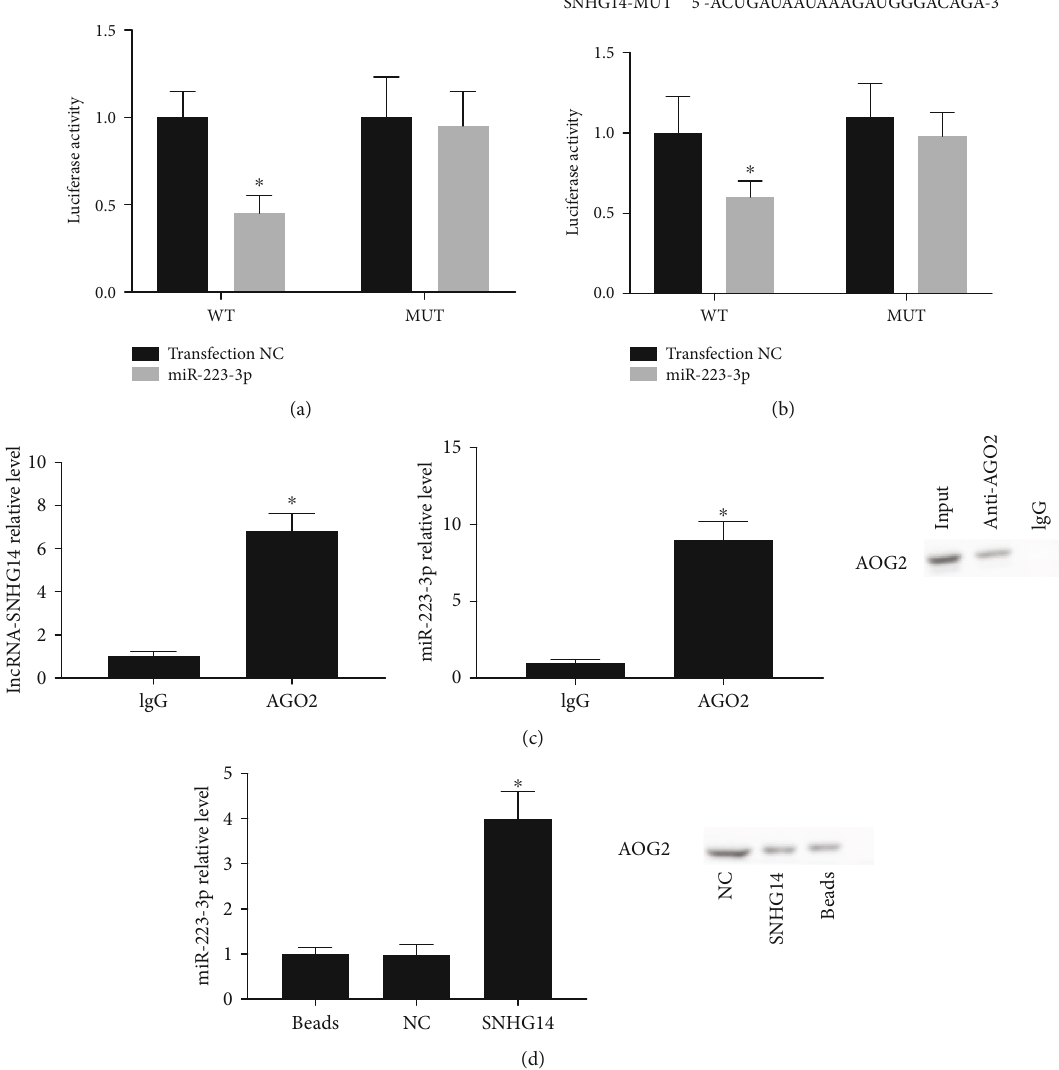
Figure 3: lncRNA-SNHG14 interacted with miR-223-3p/Foxo3a as a ceRNA. (a, b) The binding relationship of lncRNA-SNHG14/miR- 223-3p and miR-223-3/Foxo3a was determined by dual-luciferase reporter assay. (c) In RIP assay, lncRNA-SNHG14 (left) and miR-223- 3p (middle) levels in anti-AGO2 coprecipitates were measured by qRT-PCR.AGO2 binds that were detected by western blot (right). (d) In RNA pull-down assay, miR-223-3p level in biotin-labeled SNHG14 pull-down compounds was analyzed using qRT-PCR (left). AGO2 binds were detected by western blot (right). ∗ P < 0 : 05 compared with transfection negative control or lgG or RNA pull-down